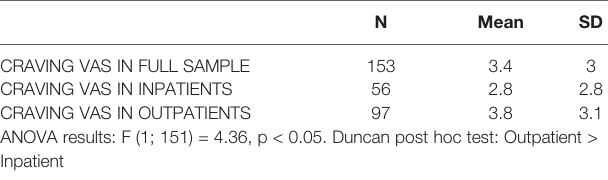
VAS, visual analogue scale.